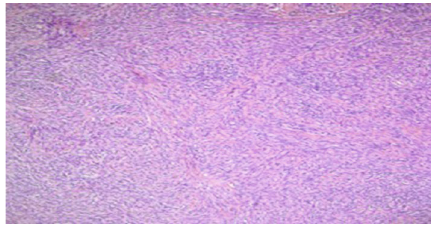
Figure 2: Hematoxylin and eosin stain demonstrating a patternless spindle cell neoplasm ( × 10 magni fi cation).